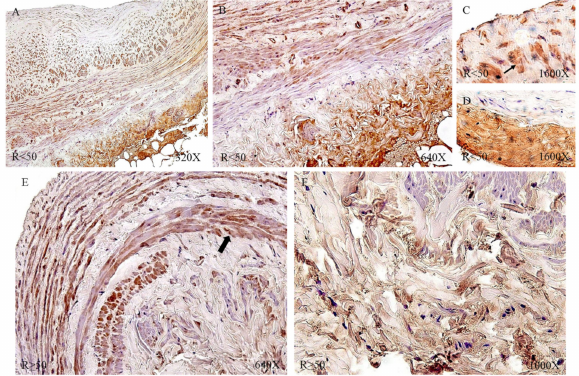
Figure 8. Images showing tropoelastin protein expression in patients with R < 50 ( A – D ) and R > 50 ( E , F ). 3.3. Young Patients with Venous Reflux Show Increased Levels of Fibulin 5 Expression The quantification of the gene expression for fibulin 4 (FBLN-4) did not show